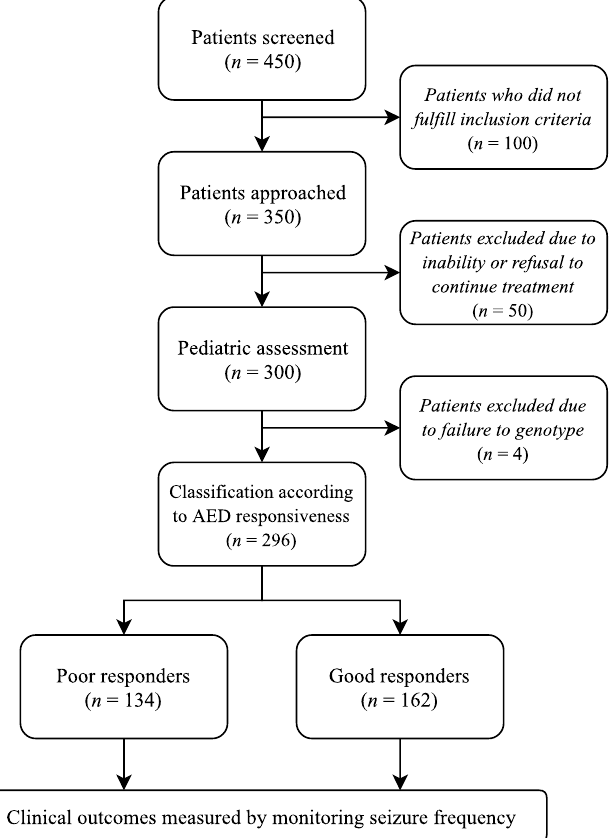
Figure 1. Flow chart of epileptic patients ( N = 296).